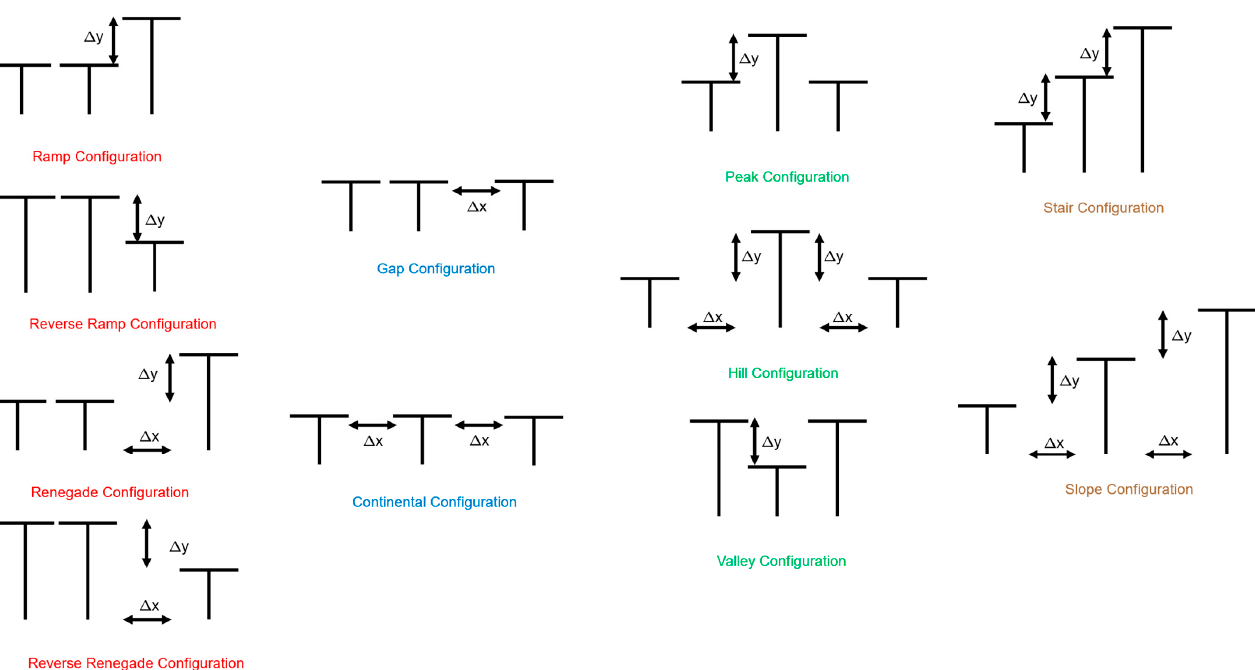
Figure 2. General three-pad configurations, where altering Δ x or Δ y will change the pad separation for that given configuration. No horizontal spacing was used if there is no Δ x shown.